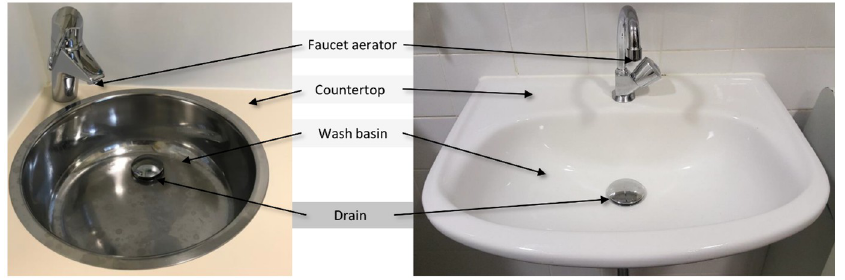
Fig 1. Sink surfaces cultured during every sampling moment. Shown are the sites that were swabbed during every sampling moment. The drain plugs that were installed are shown covering the drains of two different sinks included in the intervention. The inner sink environment comprised the drain (dark grey), and the outer sink environment comprised the faucet aerator, countertop, and wash basin (light grey). Drain wells and p-traps/siphon water were also part of the inner sink environment, but these are not shown in the